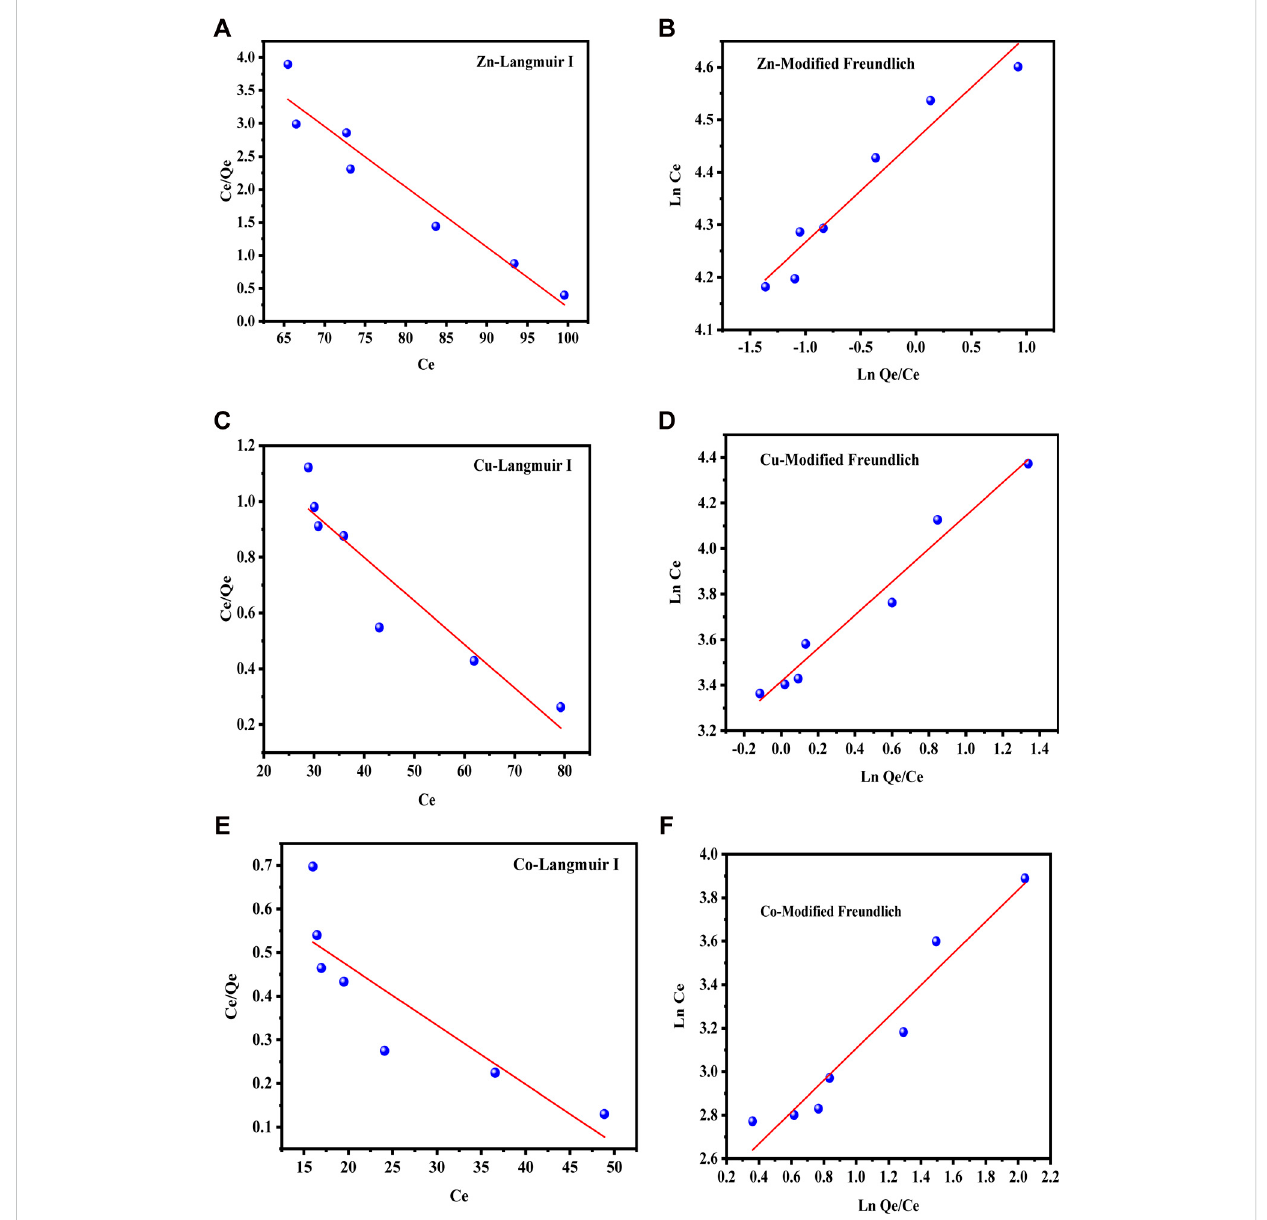
FIGURE 7 (A – F) Langmuir and Freundlich isotherm sorption models of Zn(II), Cu(II), and Co(II) on SBL from soil samples.